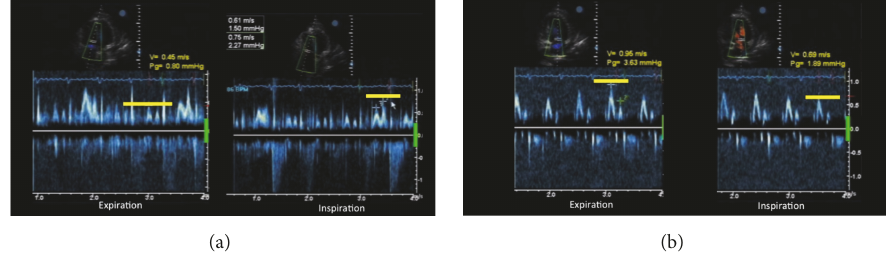
Figure 5: Exaggerated respiratory variations in tricuspid and mitral valve inflow. During inspiration, there was a significant increase in velocity for the tricuspid valve (a), while the mitral valve exhibited decreased inflow velocity